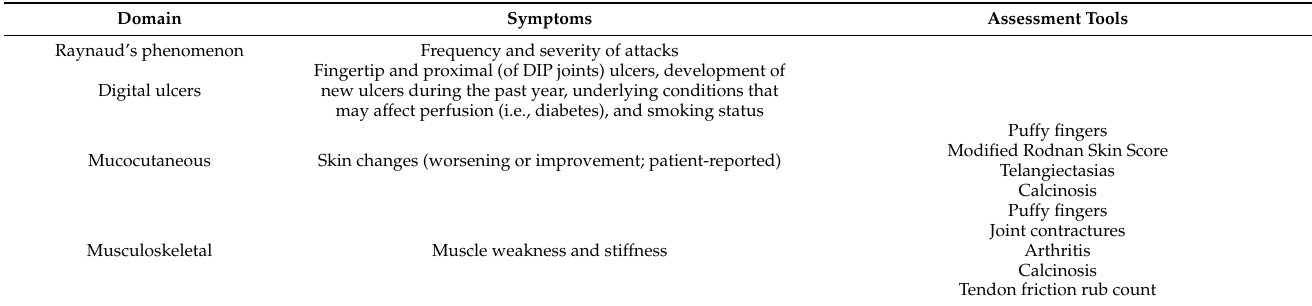
Table 3. Annual assessment of organ involvement in systemic